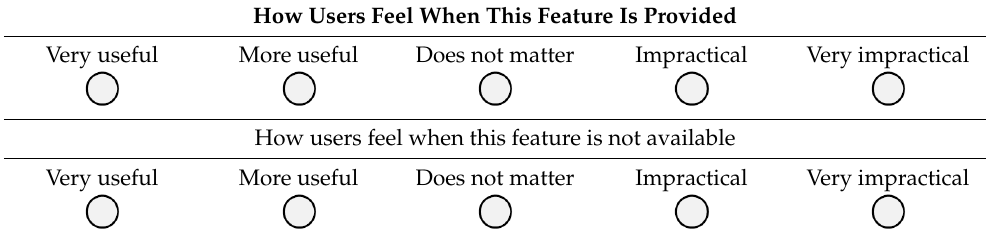
Table 1. Example of Kano two-factor questionnaire. How Users Feel When This Feature Is Provided Very useful More useful Does not matter Impractical Very impractical